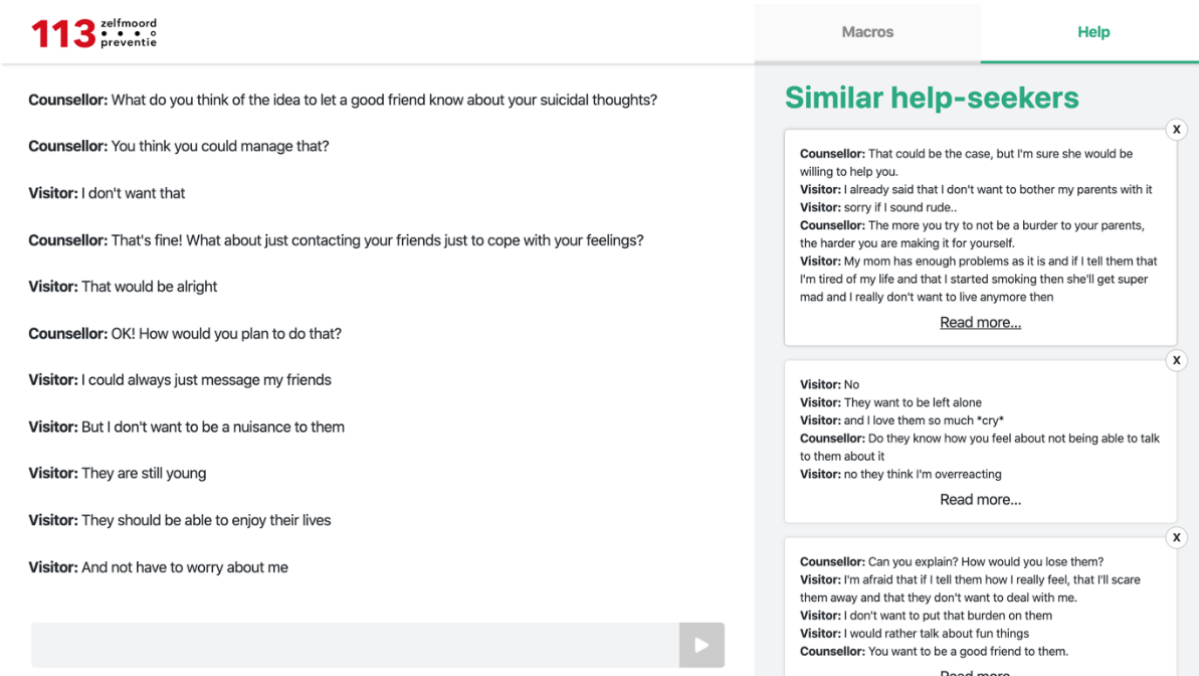
Figure 1. Interface support system (right). Content translated from